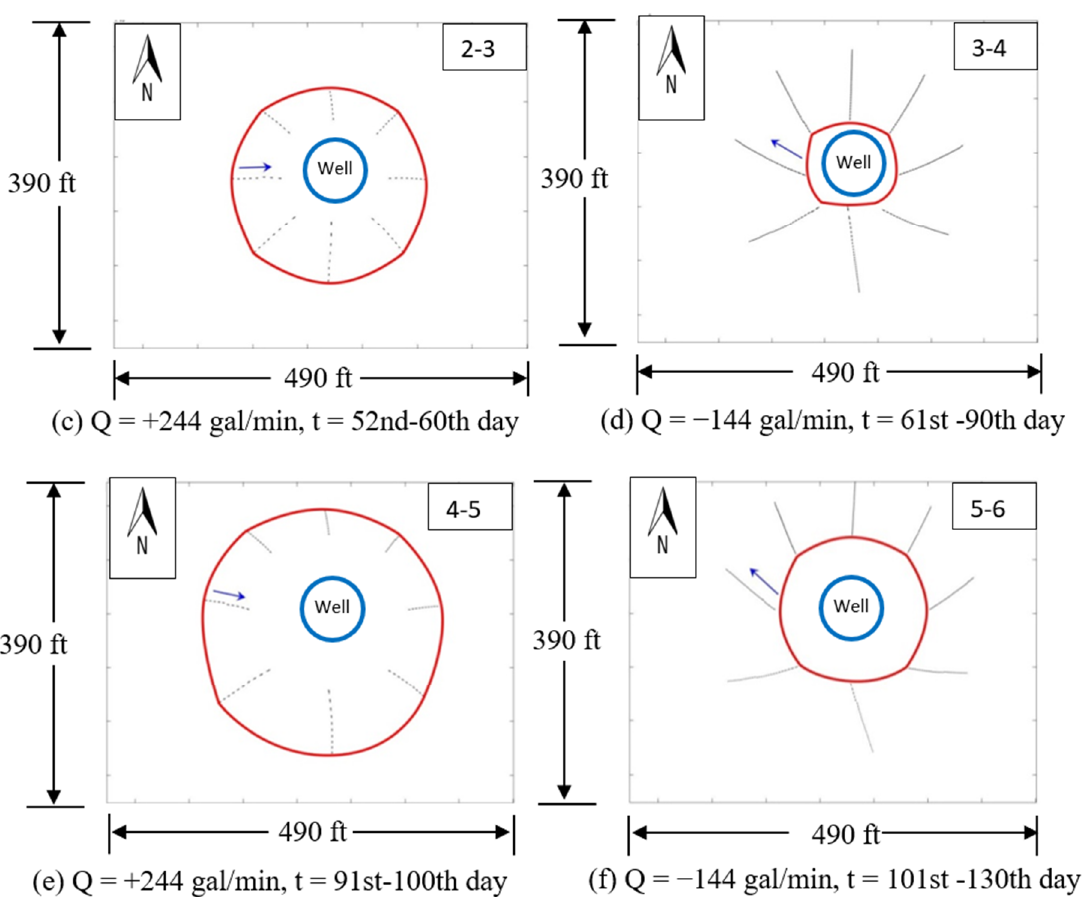
Figure 6. Water circles around a well for 130 days under pumping and injection conditions at the Meadows Pumping Center, CO, USA. ( a , c , e ) represent the pumping process during the periods of the 1st–21st day, 52nd–60th day, and 91st–100th day. ( b , d , f ) represent the injection process during the periods of the 22nd–51st day, 61st–90th day, and 101st–130th day.